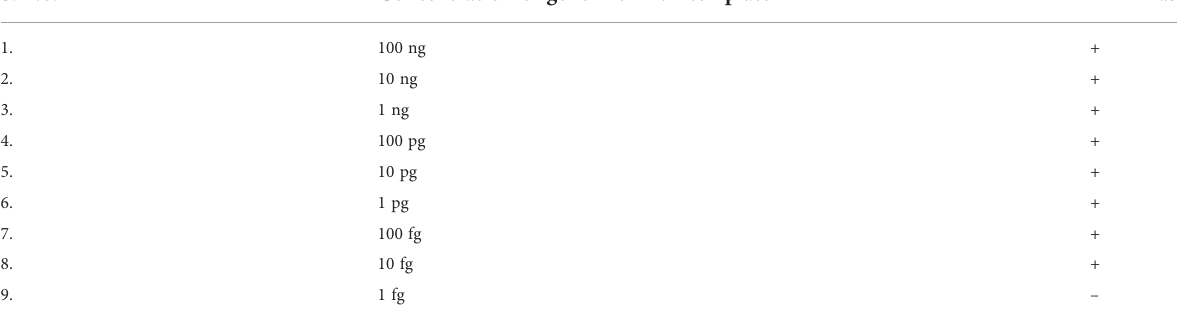
TABLE 3 Sensitivity of LAMP assay for the detection of S. oryzae targeting b -tubulin gene. S.